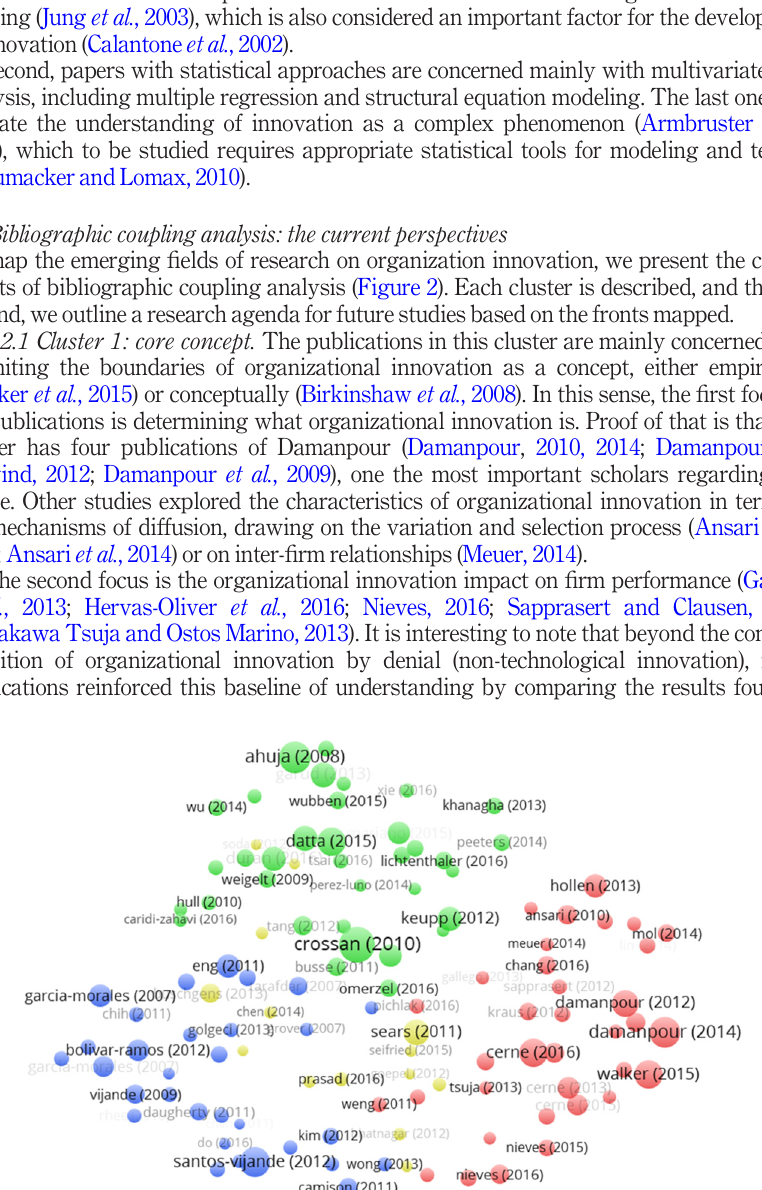
Figure 2. Bibliographic coupling cluster